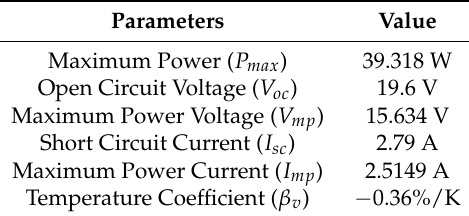
Figure 13. Variation of temperature. Table 1. PV cell